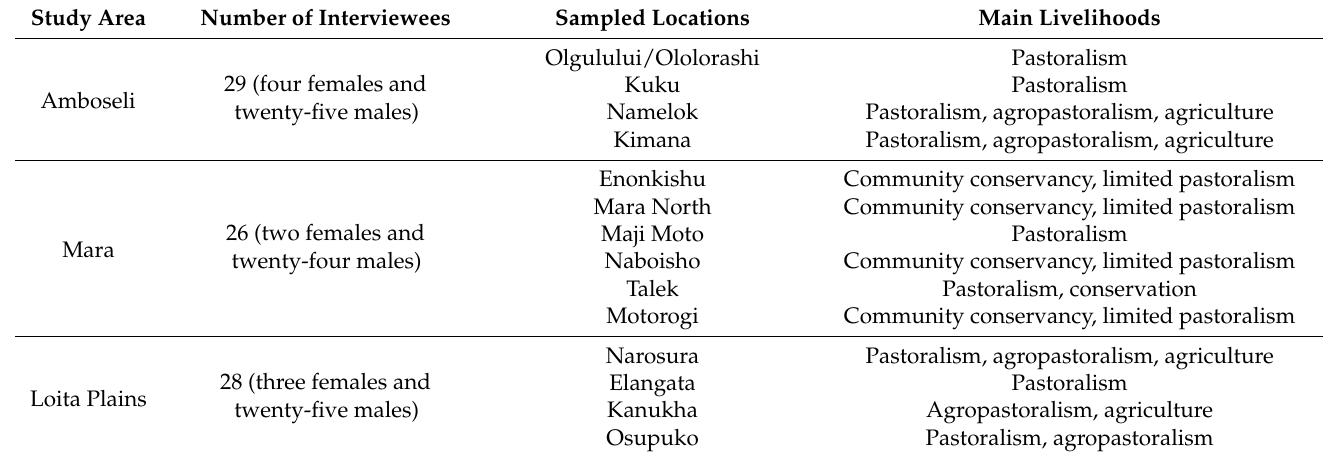
Table 1. Sampled locations in the study areas and livelihoods